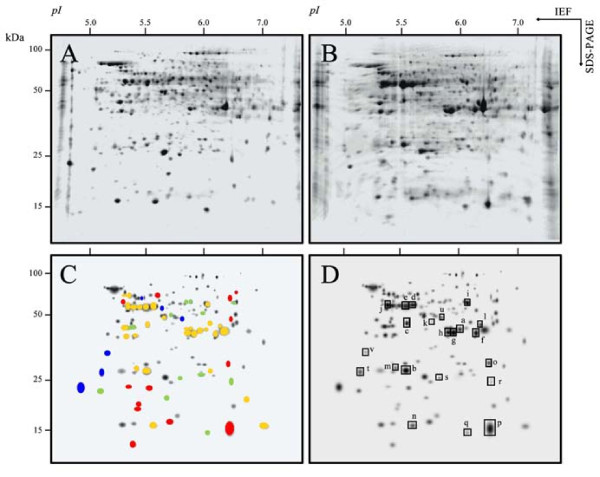
2-D IEF-SDS PAGE proteome maps of root tips from Fe-sufficient and Fe-deficient Beta vulgaris plants. Proteins were separated in the first dimension in linear (pH 5-8) IPG gel strips and in the second dimension in 12% acrylamide vertical gels. Scans of real typical gels of root tips from Fe-sufficient and Fe-deficient plants are shown in A and B, respectively. Virtual composite images, showing all polypeptides present in root tips from Fe-deficient and Fe-sufficient plants are shown in panels C and D. Statistical significance was assessed with a t-test (p < 0.10), and a 2-fold change in spot intensity between treatments was used as a threshold. Only spots that fit both criteria are marked in panel C; spots whose intensities decrease or disappear completely with Fe deficiency were labelled with green and blue marks, respectively, and those increasing with Fe deficiency or only present in Fe-deficient gels were labelled with yellow and red marks, respectively. In panel D, polypeptides that had significant homologies with proteins in the databases (using MALDI-MS and MASCOT) are marked by squares and labelled with lower-case letters. Homologies are described in detail in Table 1.